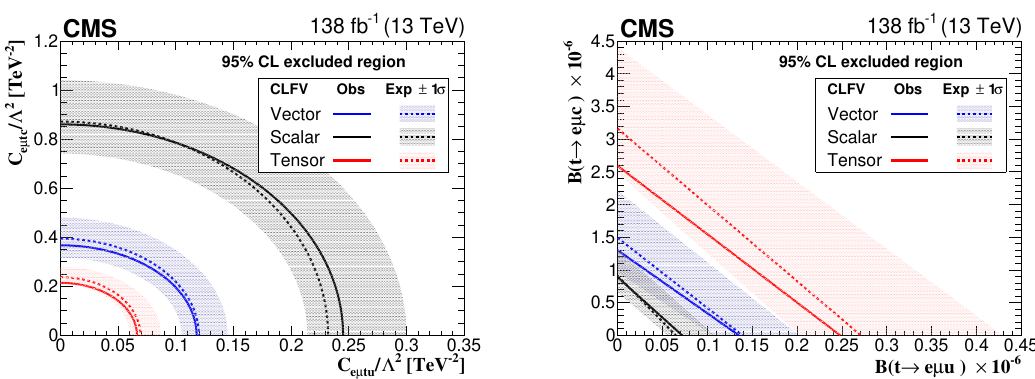
Figure 5 . The observed 95% CL exclusion limits on the e m tc ; of the e m tu Wilson coefficient (left) and B (t → e m c) as a function of B (t → e m u) (right) for the vector-, scalar-, and tensor-like CLFV interactions. The hatched bands indicate the regions containing 68% of the distribution of limits expected under the background-only